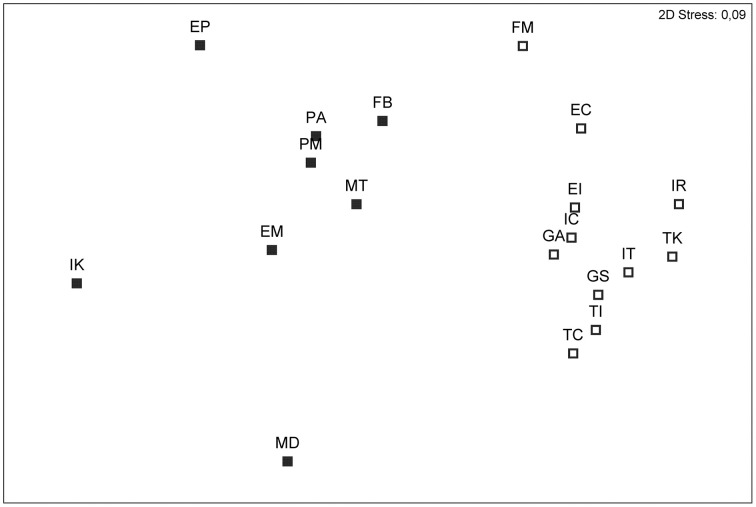
Non-metric multidimensional scaling (nMDS) showing genetic distances between 19 populations of Arbutus unedo. Genetic distances were estimated as pairwise FST values obtained after inferring allele frequencies with the Bayesian method of Zhivotovsky (1999) implemented in AFLP-SURV. Open symbols are populations assigned to the Mediterranean genetic group, closed symbols are populations assigned to the Atlantic group. See Materials and Methods for population names.